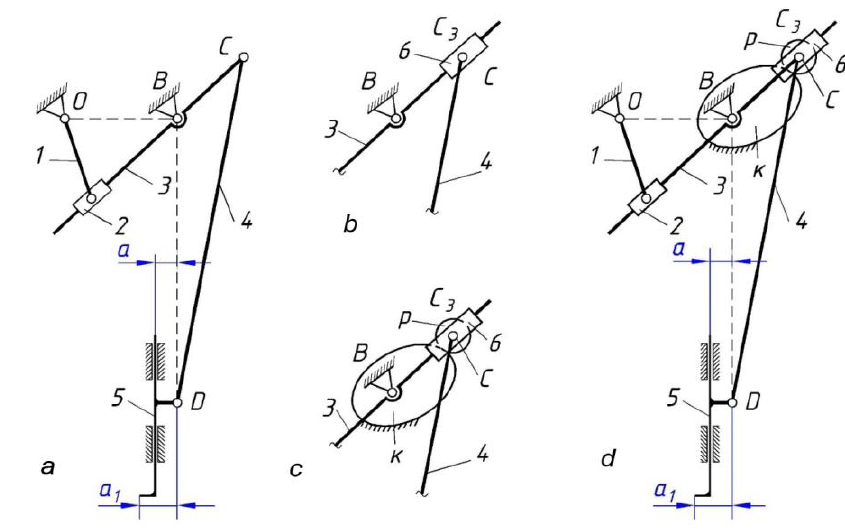
Fig. 3. The steps of modernization of the structural scheme of the mechanism of the slotting